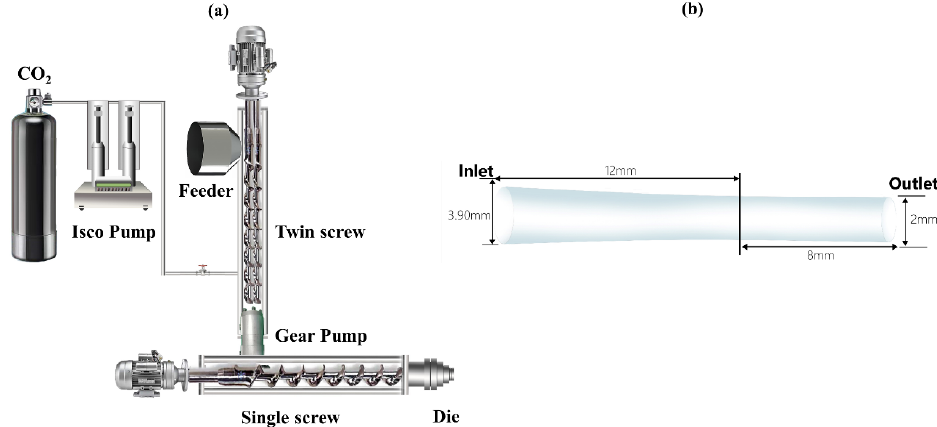
Figure 3. Schematic diagram of ( a ) extrusion foaming system; ( b ) the die channel.